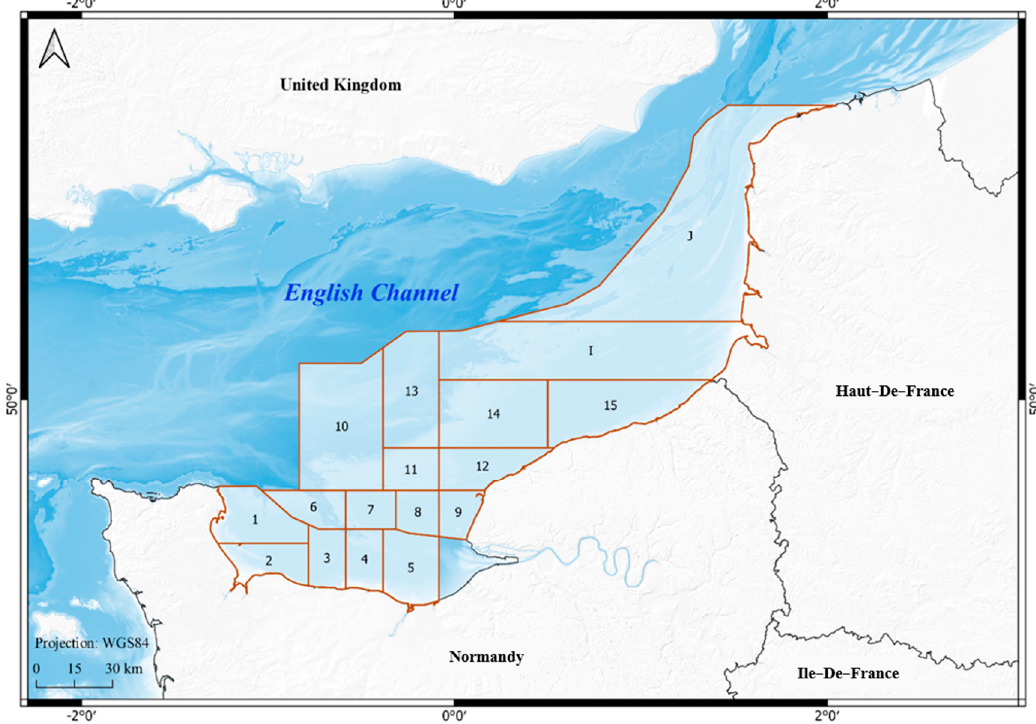
Figure 1. Location map of the study area (zones from 1 to J represent the scallop management areas or production areas).